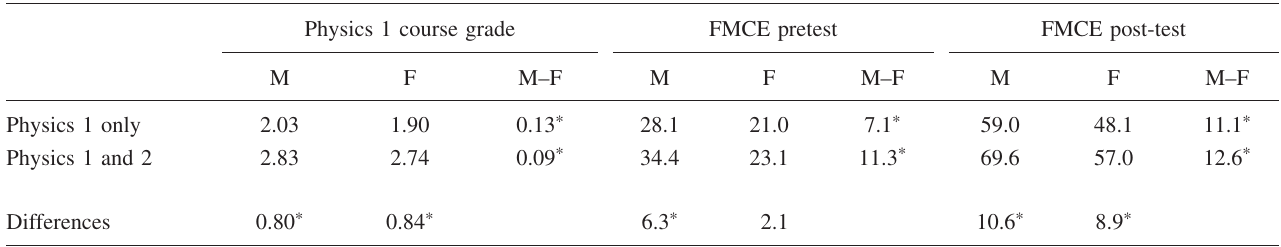
TABLE III. Gender gaps in course grades and FMCE for those students who took Physics 1 but then did and did not take Physics 2. The differences in the bottom row are (cid:1) Physics 1 and 2 – Physics 1 only (cid:2) . The asterisk (cid:1) (cid:1) (cid:2) indicates that the difference is significant at the p (cid:1) 0.05